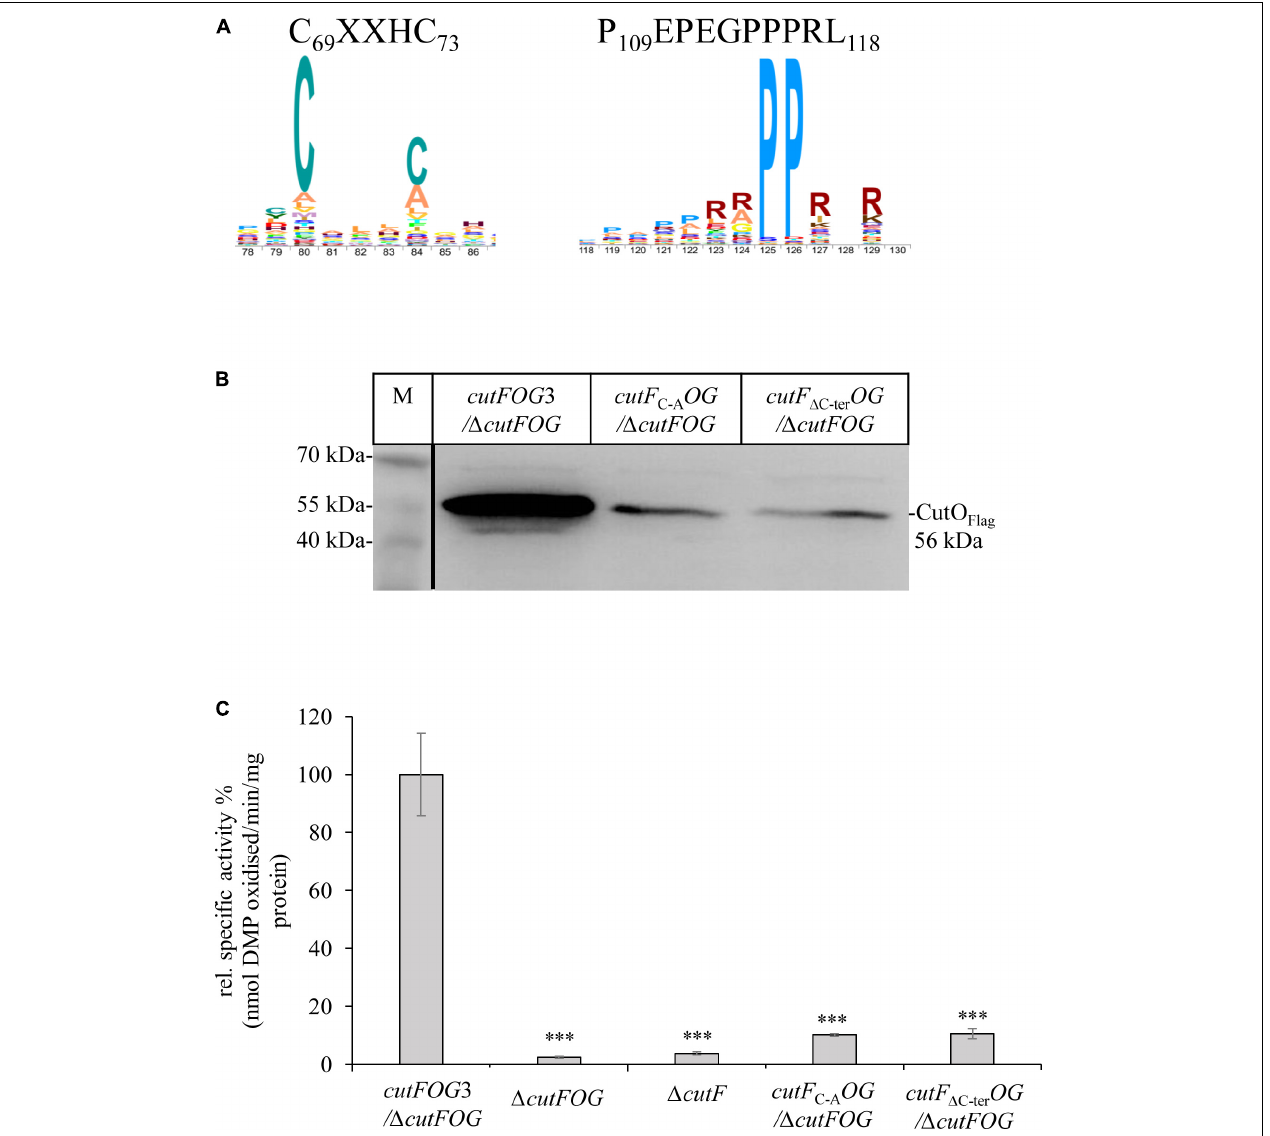
FIGURE 5 | The conserved cysteine motif and the proline-rich C-terminus of CutF are essential for its function. (A) Sequence logo of the conserved CutF motifs. (B) Immunoblot analysis of the CutO proteins from the strains carrying the cutF C − A OG (Substitution of putative Cu binding C 69 XXXC 73 motif by A 69 XXXA 73 ) and cutF (cid:49) C − ter OG (truncation of C-terminal proline-rich region, P 109 EPEGPPPRL 118 ) plasmids producing the CutF C − A and CutF (cid:49) C − ter mutant proteins, respectively. In both plasmids CutO was C-terminally Flag-tagged. 200 µ g of soluble protein and α -Flag antibodies were used for the detection of CutO. 15% SDS-PAGE was used for separation. (C) CutO activities in the (cid:49) cutFOG strain expressing either cutFOG3 ( cutF N − Flag O Flag G MycHis ) or the mutated cutF C − A OG or cutF (cid:49) C − ter OG variants. In all cases, CutO was C-terminally Flag-tagged. The (cid:49) cutFOG and the single (cid:49) cutF mutants served as an additional control. Strains were grown on MPYE medium in the presence of 10 µ M CuSO 4 . 50 µ g of the same soluble protein from the periplasmic fractions were used in the assay. Three independent experiments were performed with three technical repetitions and the error bars reflect the standard deviation ( n = 9). Statistical analyses were performed as in Figure 1 , using the cutFOG3 / (cid:49) cutFOG strain as reference. ( ∗ ) refers to p - values ≤ 0.05; ( ∗∗ ) to p -values ≤ 0.01, and ( ∗∗∗ ) to p -values ≤